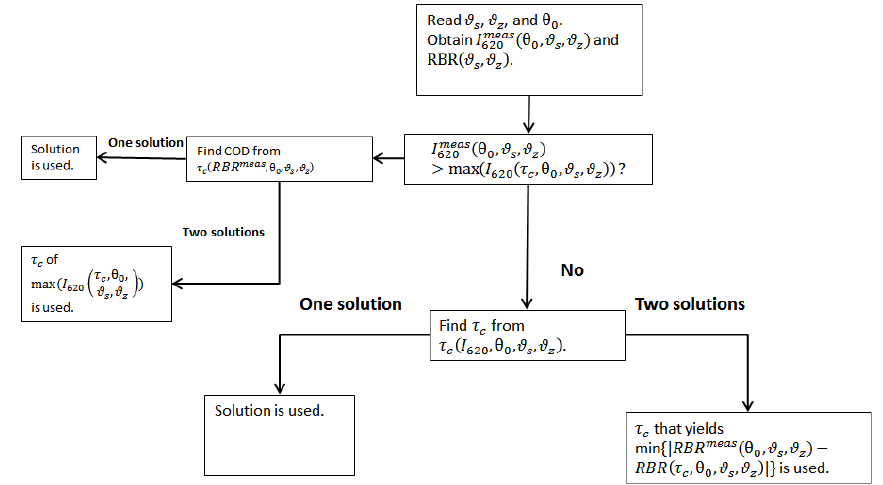
(θ 0 ,ϑ s , ϑ z ) is saturated (e.g., in the solar disk), 620